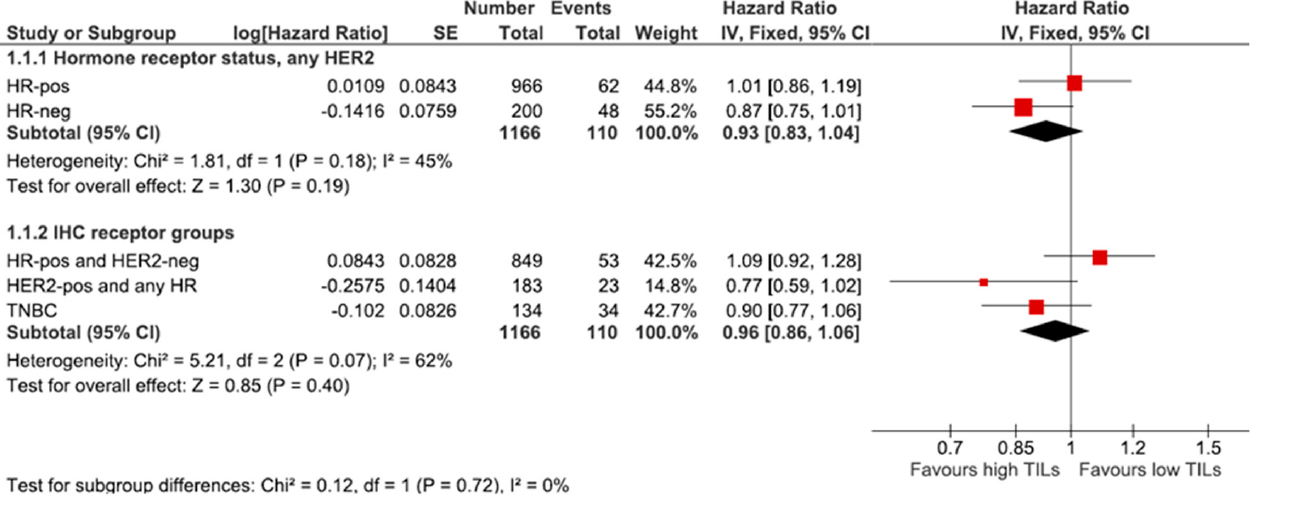
Figure 3. Forest plot for the effect of TILs infiltration per 10% increment in different receptor groups regarding the RFI. Red box: point estimate of the effect for a single group, diamond: overall effect estimate of all groups